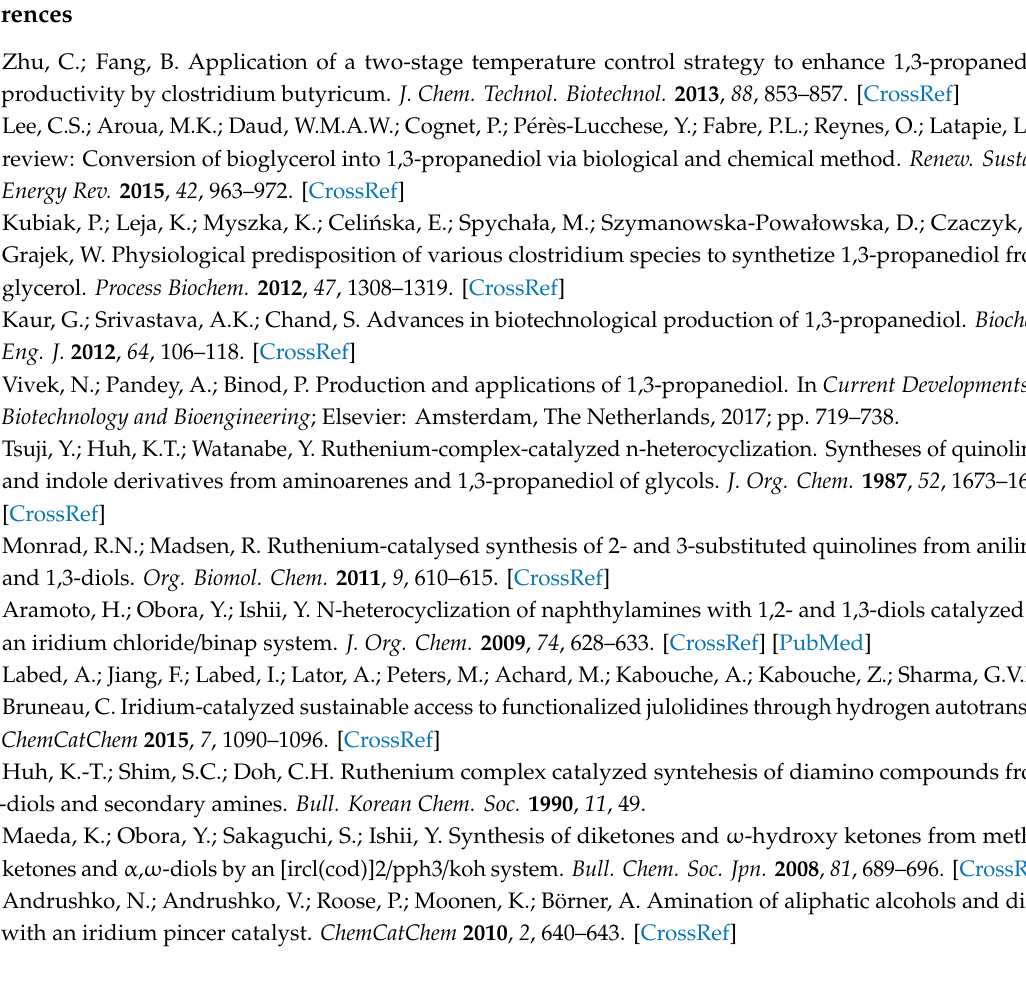
Figure S1: Batch fermentation with free cells of C. butyricum performed with initial concentration of 51.6 g / L of pure glycerol. Table S1: Comparison of published data on fermentation of crude and pure glycerol by strains of C. butyricum. Table S2: Comparison of repeated batch fermentation performed by entrapped cells, cells spontaneously immobilised on the surface of PVA particles, and free cells, using pure or crude glycerol produced from rapeseed oil (RO) and used cooking oil